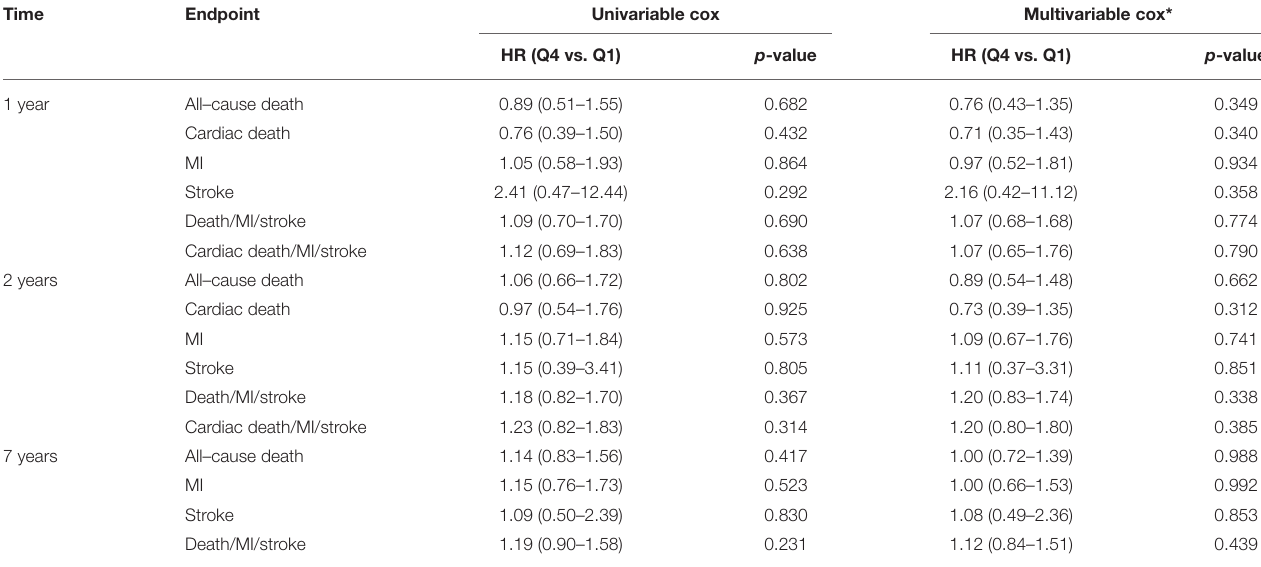
TABLE 3 | Association between podocan and all endpoints in the total population. Time Endpoint Univariable